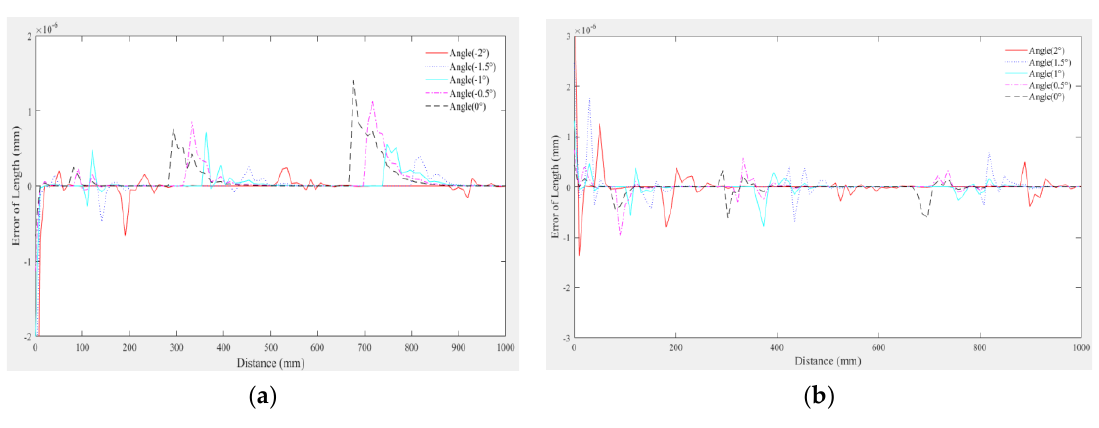
Figure 2. Simulation distribution of measurement length deviation of different distances of step gauge with different attitude angle θ ; ( a ). θ is a negative angle, which means the normal direction of the measured surface and the starting zero plane of the step gauge is opposite; ( b ) when θ is a positive angle, the normal direction of the measured surface and the starting zero plane of the step gauge are the same.